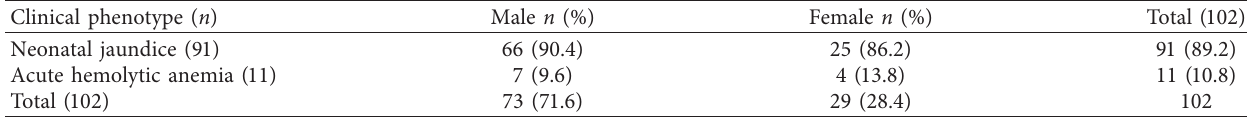
Table 1: Clinical phenotypes of 102 G6PD-deficient Thai